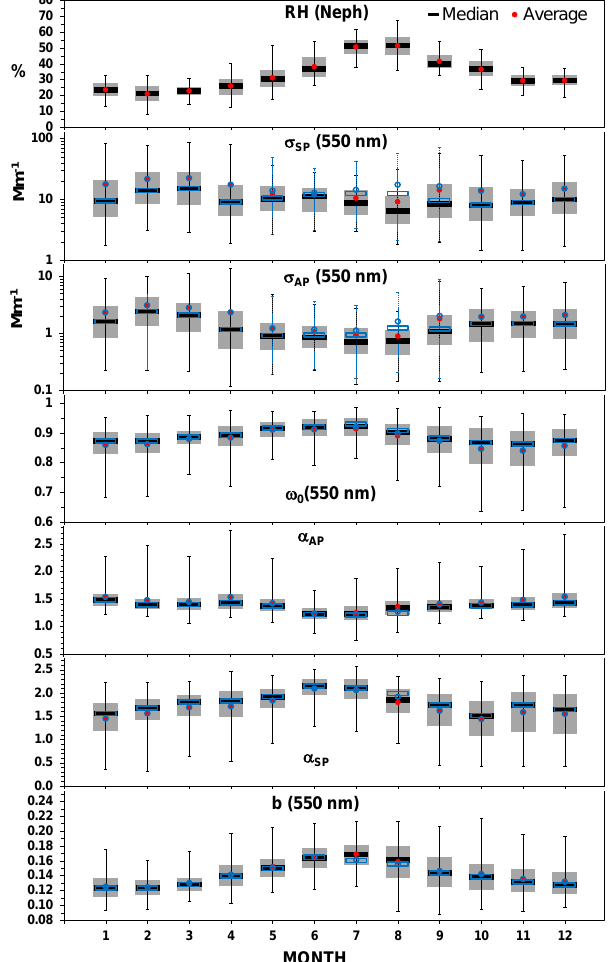
Fig. 5. Seasonal cycle selected extensive and intensive aerosol op- tical properties: scattering coefficient ( σ SP ) and absorption coef- ficient ( σ AP ) single-scattering albedo ( ω 0 ) , ˚Angstr¨om exponent of absorption ( α AP ) and scattering ( α SP ) , and the backscatter fraction ( b ), and relative humidity measured in the nephelometer sample volume (RH Neph ) in 13 October 2006–31 May 2009. The grey box represents the 25th to 75thpercentile range and the thin bars the 95percent range (2.5th and 97.5thpercentiles) of the hourly- averaged data in each month. The black line and the red circle for the optical properties represent the mean and median of those data where RH NEPH < 50% and the respective blue symbols all data without RH filtering. For RH NEPH all data were used for the